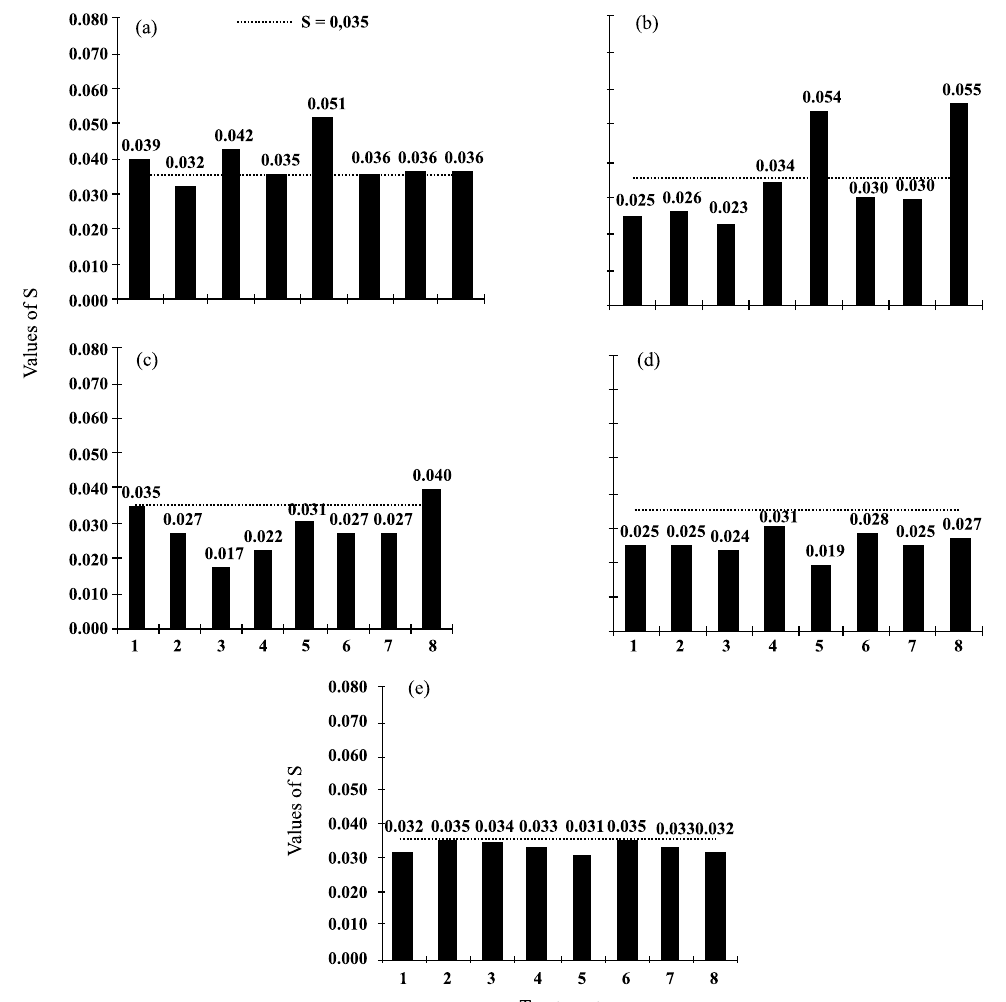
Figure 4. S values observed after cover crop desiccation in the first year of the experiment (2003/2004) as affected by soil depth. (a) 0–0.05 m; (b) 0.075–0.125 m; (c) 0.15–0.20 m; (d) 0.275–0.325 m and (e) 0.475– 0.525 m. Treatments: 1) sunflower + pearl millet; 2) sunflower + sorghum; 3) sunflower + sunn hemp; 4) sunflower + chiseling; 5) triticale + pearl millet; 6) triticale + sorghum; 7) triticale + sunn hemp and 8) Triticale +